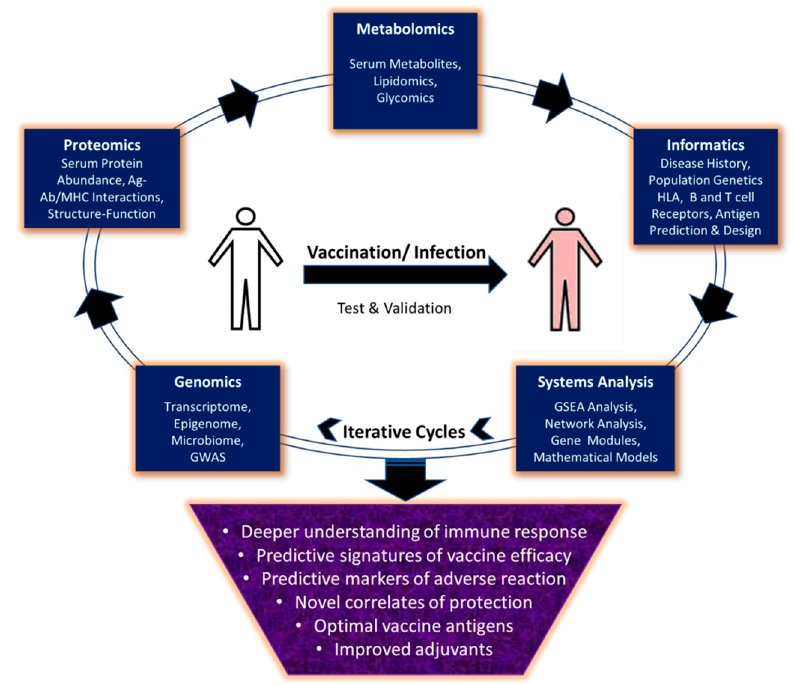
Figure 1. Applications of Omics methodologies and systems biology in vaccine development.